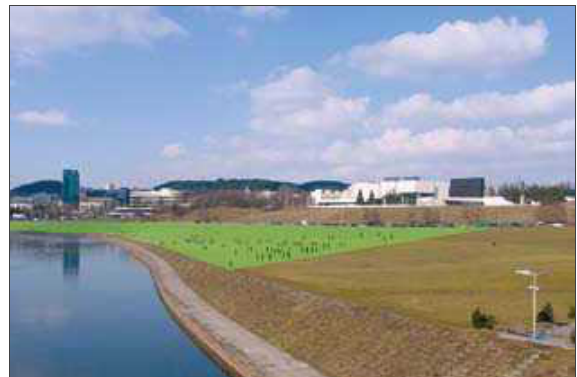
16 pav. Natūralios gamtos išsaugojimo idėja Neries krantinės viešojoje erdvėje (archit. G. Čaikauskas) Fig. 16. Idea of preserving natural public space on the Neris riverside (arch. G. Čaikauskas)